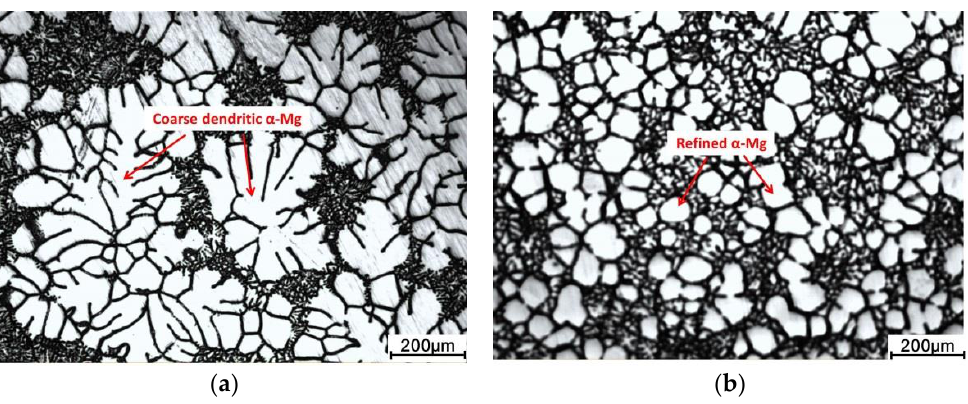
Figure 4. Microstructure of semisolid AZ31 alloy quenched at 610 °C. ( a ) Conventional solidification; ( b ) after the slurry preparation procedure.